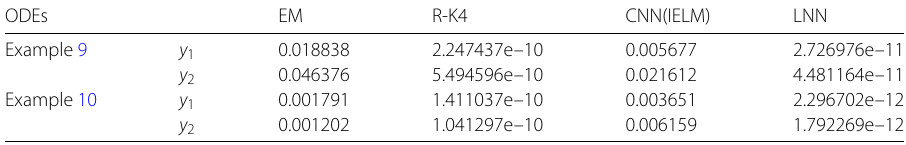
Table 9 Execution time of different methods for SODE ODEs EM R-K4 Example